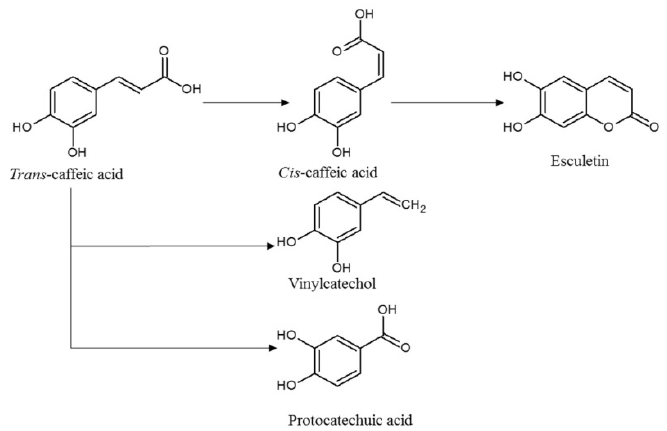
Figure 1. Proposed mechanism for the photodegradation of trans- CA [6].